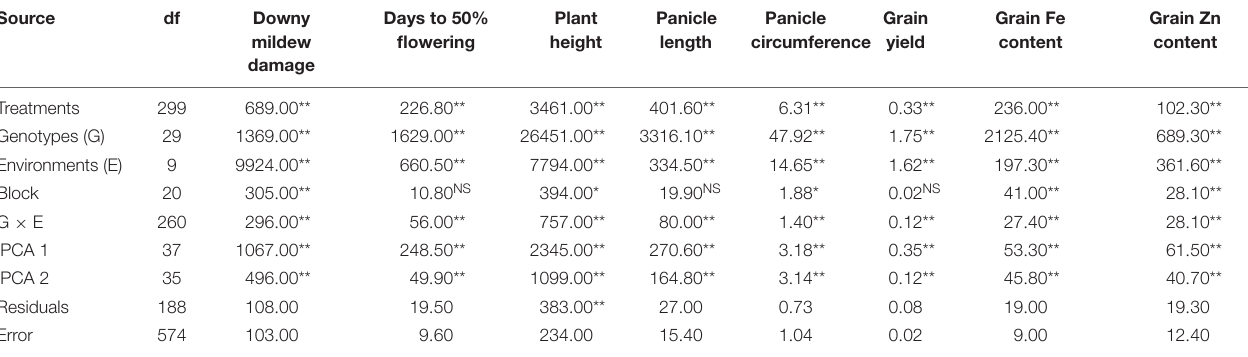
TABLE 3 | Analysis of variance for AMMI model of pearl millet genotypes across locations in West Africa. Source df Downy